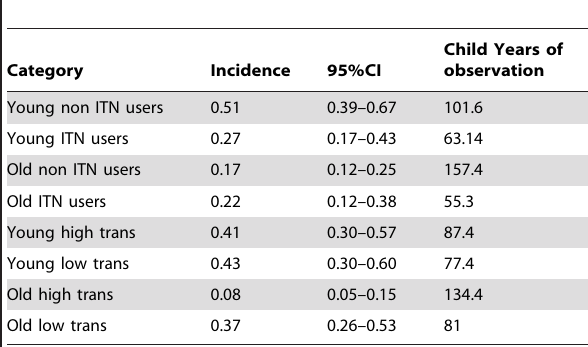
Table 1. The incidence rates of febrile malaria by age and ITN use.